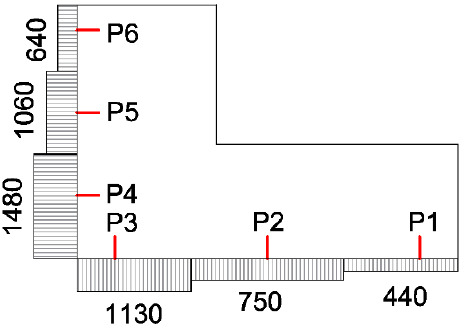
Figure 7. Validation of the OpenFOAM ® model using a physical test with regular waves of H = 0.203 m and T = 2.62 s: ( a ), ( c ), and ( e ) display up-lift pressures, and ( b ), ( d ), and ( f ) display horizontal pressures.